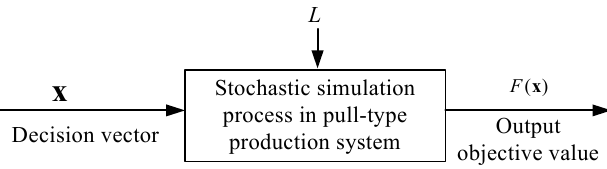
Figure 4. The input–output relationship in pull-type production system.